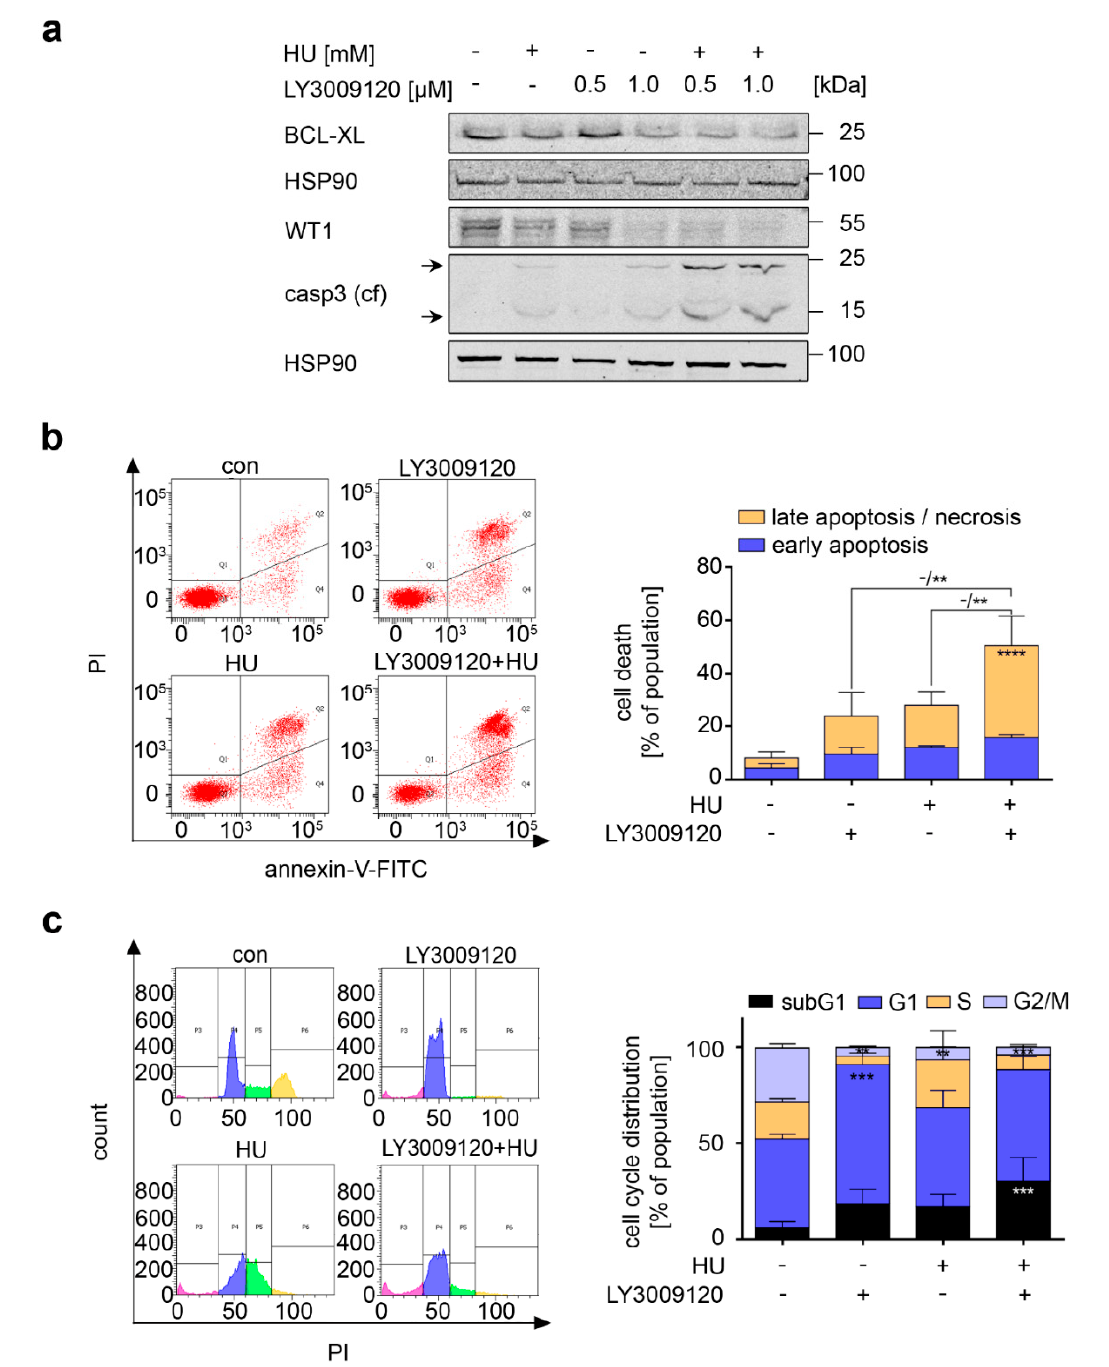
Figure 5. Replication stress and RAF inhibition combine favorably against FLT3-ITD positive AML cells. ( a ) MV4-11 cells were treated with 0.5 mM hydroxyurea (HU) and 0.5 or 1.0 µM LY3009120 for 24 h. Immunoblot shows expression of BCL-XL, WT1, and cleaved caspase-3 (casp3 (cf), caspase 3—cleaved form); HSP90 serves as loading control—note that each membrane was tested for equal loading with HSP90 and shown are the corresponding data for these experiments. ( b ) Left: Representative dot plots of MV4-11 cells treated with 1 µM LY3009120 and 0.5 mM HU for 24 h. Right: Cell death of such MV4-11 cells was measured via annexin-V/PI staining; n = 3 ± SD; two-way ANOVA; Bonferroni’s multiple comparisons test: ** p < 0.01; **** p < 0.0001. ( c ) Left: Exemplary histograms of MV4-11 cells treated with 1 µM LY3009120 and 0.5 mM HU for 24 h. Right: Shown are cell cycle distributions of MV4-11 cells treated as shown above; n = 3 ± SD; two-way ANOVA; Bonferroni’s multiple comparisons test: ** p < 0.01; *** p < 0.001.